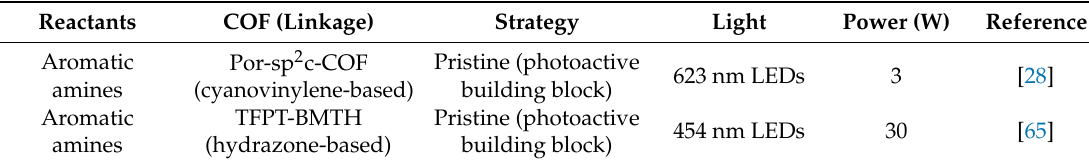
Table 11. Photooxidative couplings of primary amines mediated by